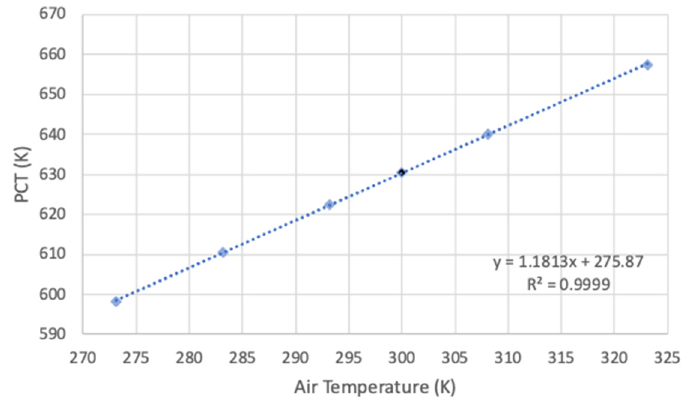
Figure 9. PCT vs. air temperature.